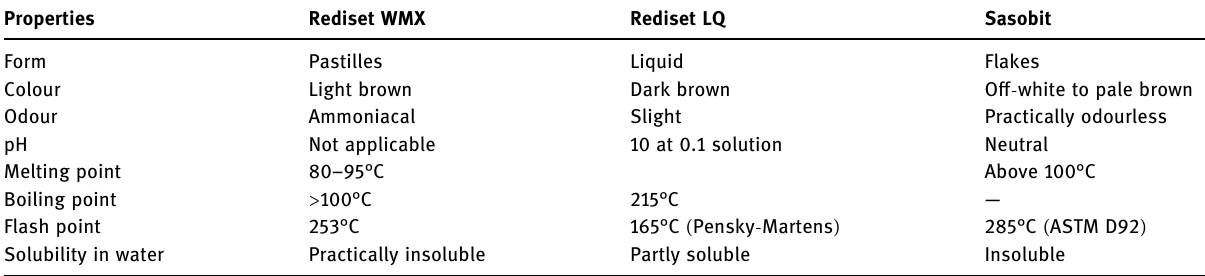
Table 2: Physical properties of additives